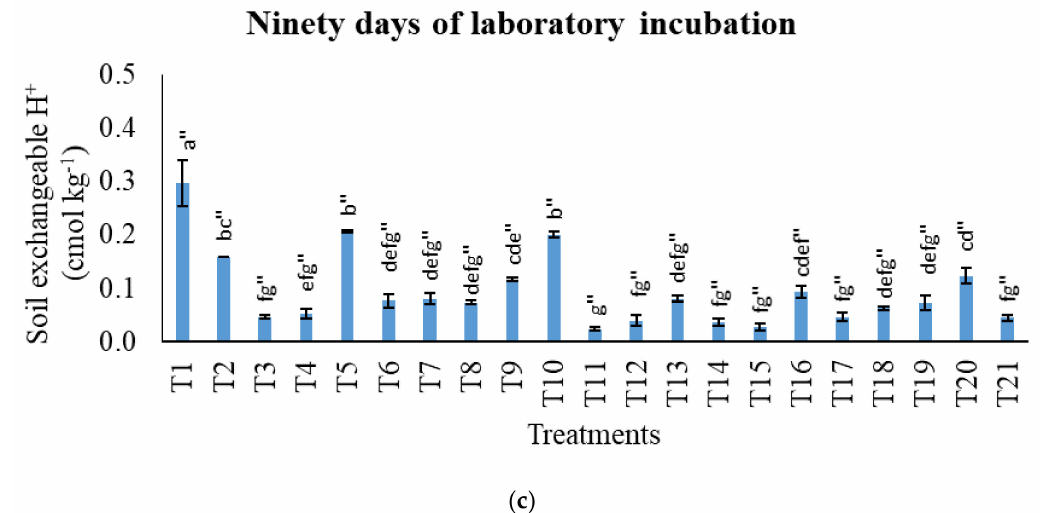
Figure 4. Effects of treatments on soil-exchangeable hydrogen over ( a ) thirty; ( b ) sixty; and ( c ) ninety days after incubation.